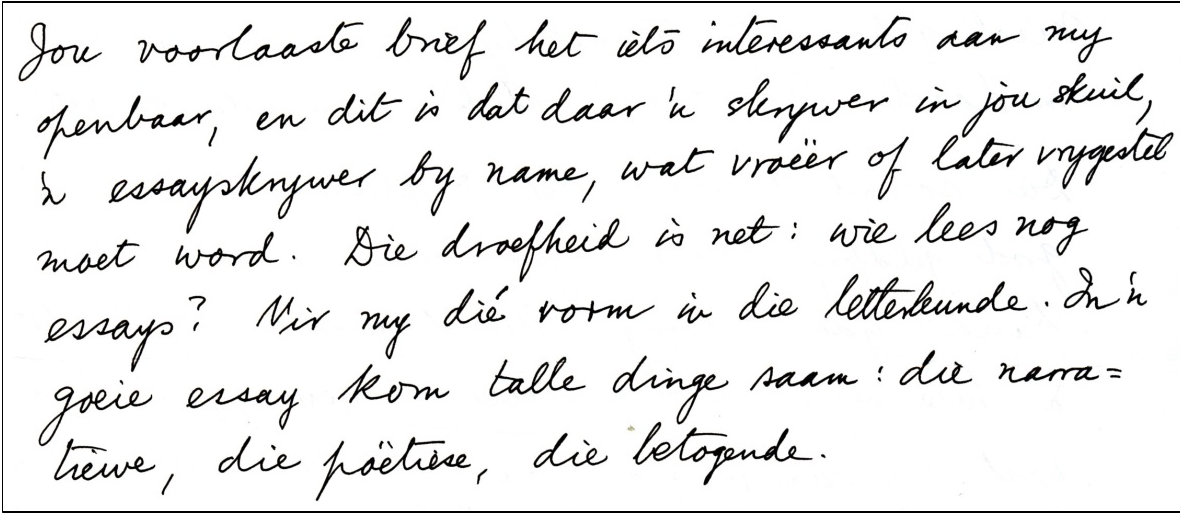
Figuur 7: Die brief van 21 Mei